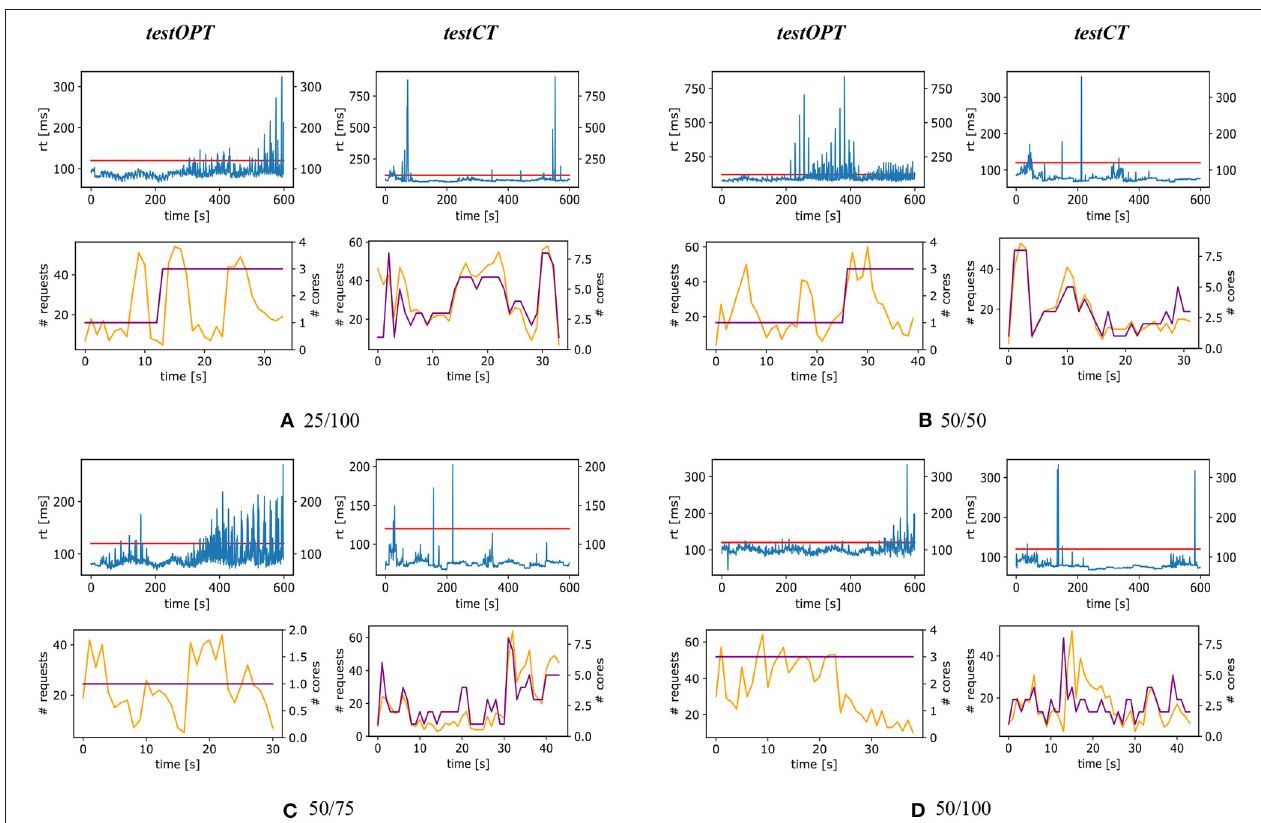
FIGURE 8 | testOPT and testCT with configurations 25 / 100 (A) , 50 / 50 (B) , 50 / 75 (C) , and 50 / 100 (D) .